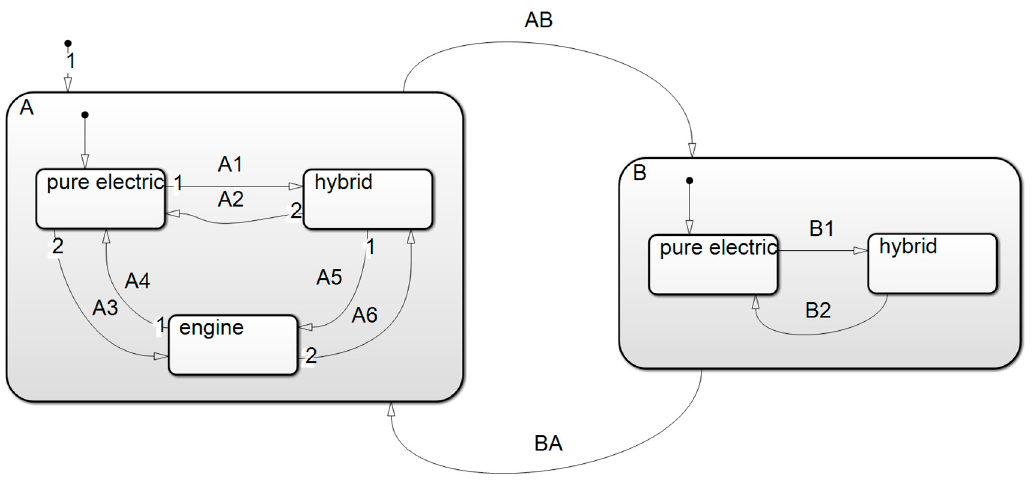
Figure 2. The state switching of the rule-based control strategy of the hybrid electric vehicle (HEV) without torque coordination.